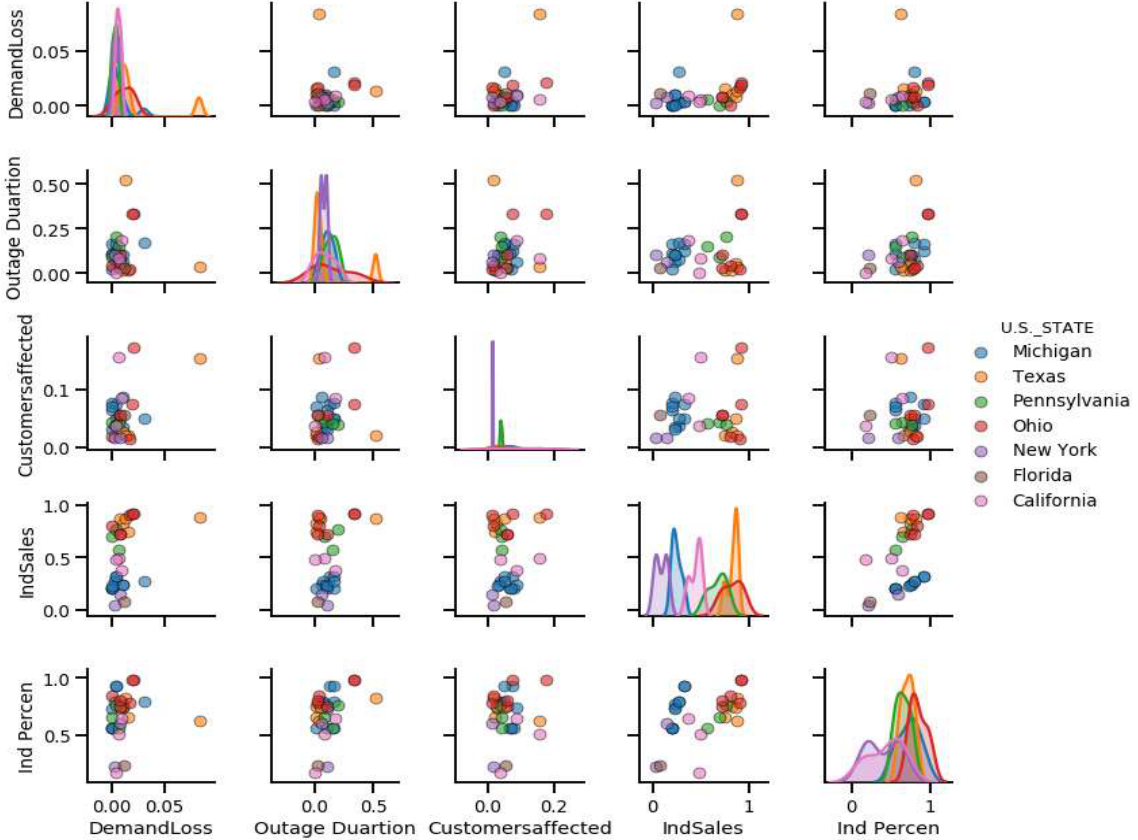
Figure 27. Inter-feature correlation among top five important features for the heavy wind cate- gory.